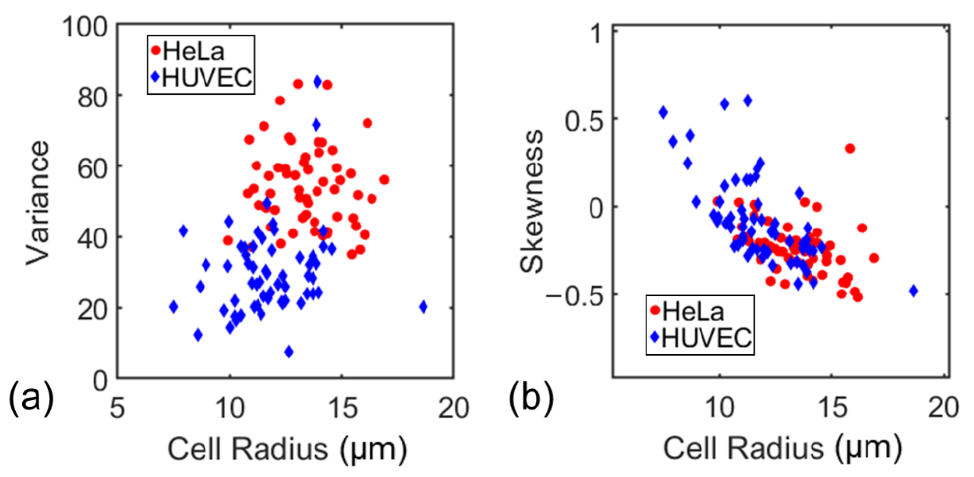
Figure 8. ( a ) The variance of the surface charge density distribution of Hela and HUVEC cells, and ( b ) the skewness of surface charge density distribution of Hela and HUVEC